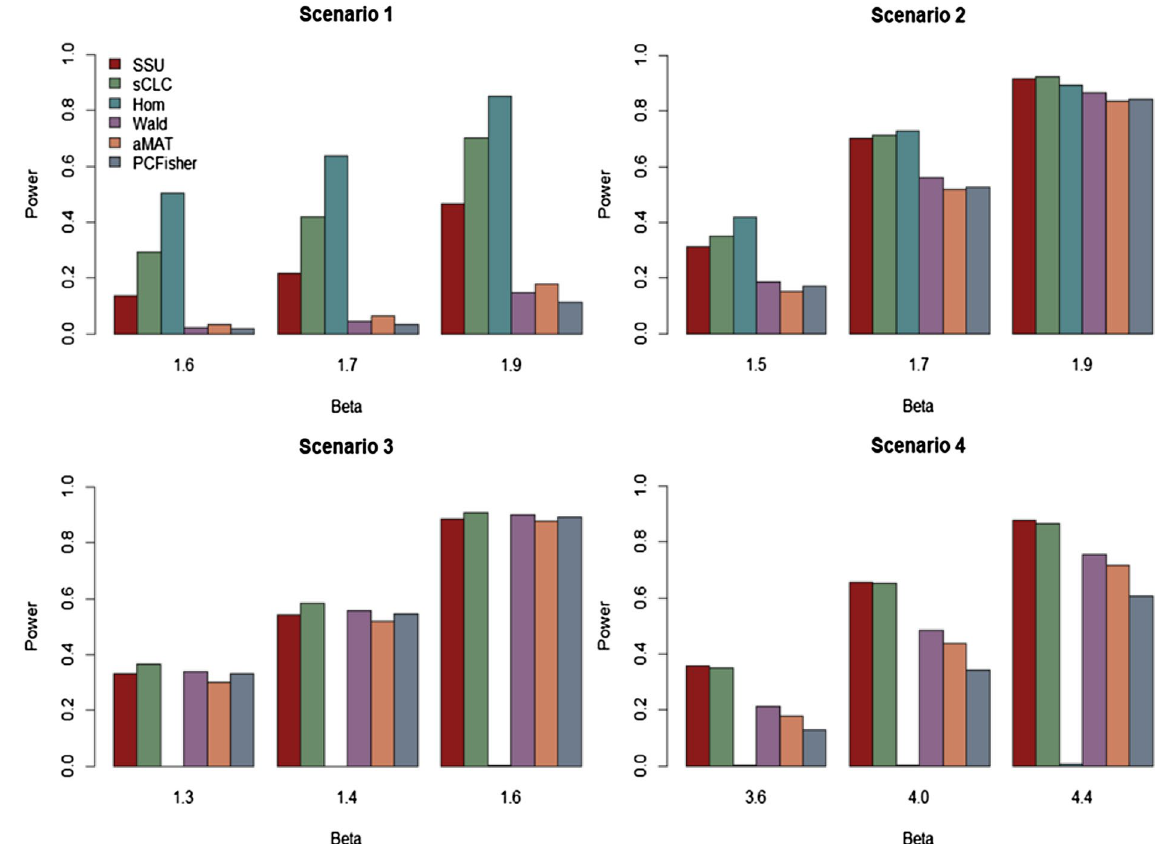
Figure 1. Power comparisons of the six methods, SSU, sCLC, Hom, Wald, aMAT, and PCFisher for the phenotypic correlation structure of the 70 phenotypes at a significant level of 5